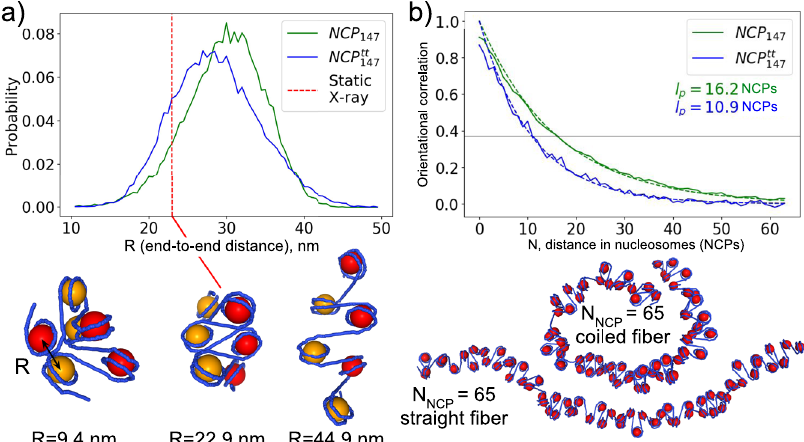
Fig. 6 Effects of DNA unwrapping on chromatin fi ber elasticity and bendability. a End-to-end distance distribution in a simulated conformational ensemble of six NCPs connected by straight 15 bp linker DNA segments. Odd and even NCPs are colored in yellow and red, respectively, to highlight the fi ber ’ s “ two-start ” structure. b Decay of orientational correlations along the nucleosome fi bers due to DNA unwrapping. Persistence length estimates are shown on the plot. Below the plot, two different conformations of the fi ber are of the nucleosomal DNA. The striking feature of the proposed shown that nucleosome remodelers use such distortions for distortion is that the tracking DNA strand shifts its register nucleosome sliding by moving nucleosomal DNA in a corkscrew inchworm fashion 21,24 . High-resolution cryo-EM studies revealed yet another unexpected intermediate present during the binding of nucleosome remodeling complexes at SHL ± 2 – the so-called half-twist-defects 24,28 . Half-twist-defects are characterized by local bulging of the tracking DNA strand around SHL ± 2 (this would be the top DNA strand in Fig. 2 if the remodeler binds at SHL -2). This bulging causes a speci fi c asymmetric distortion of the DNA double helix all the way to the remodeler proximal end